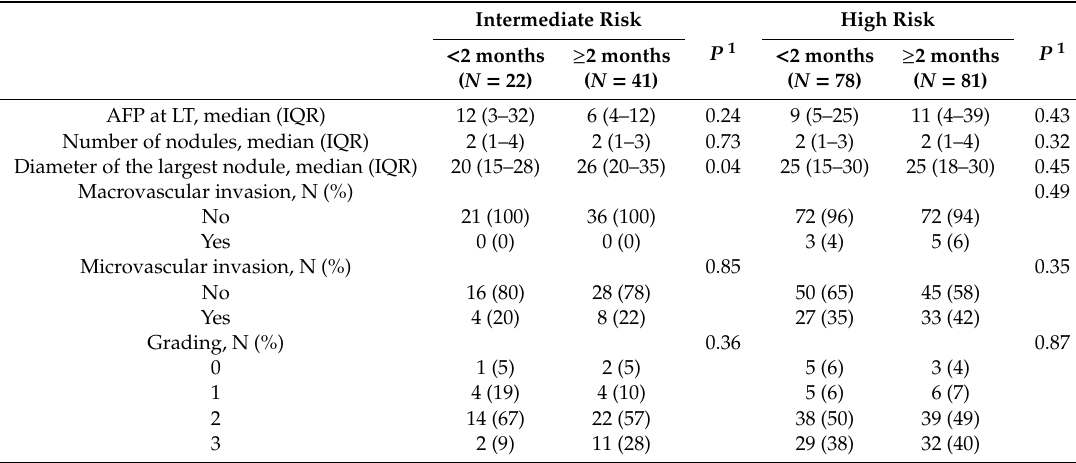
Table 3. Comparison between intermediate and high-risk patients transplanted within 2 months from restaging and after 2 months from